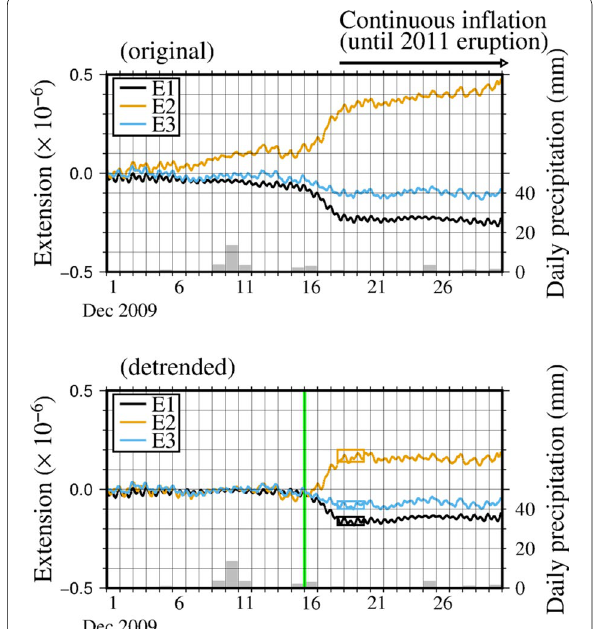
Fig. 3 Strain changes in the directions of instruments E1–E3, 1–29 December 2009. Upper panel shows the original time series. Lower panel shows the detrended time series: the linear trend is estimated during the period 1–15 December 2009 and subtracted from all plotted data. The vertical green line indicates the onset of rapid inflation that we use to estimate the strain offset. The variations within the colored boxes in the detrended graph were used to estimate the magnitude and uncertainty of the strain offset. Daily precipitation at EBN is also shown (bar graph)